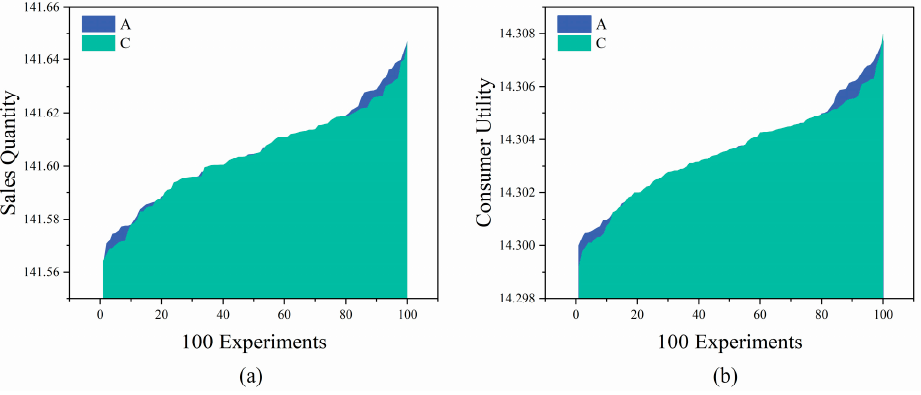
Figure 10. ( a ) Sales quantity in A and C; ( b ) consumer utility in A and C. ( t = 100).